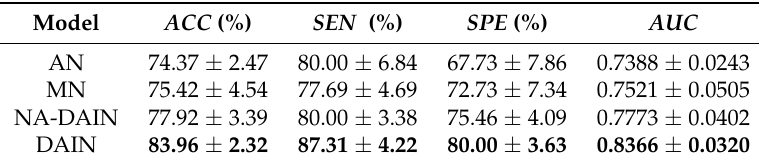
Table 6. Classification performance of different 2D models for T1